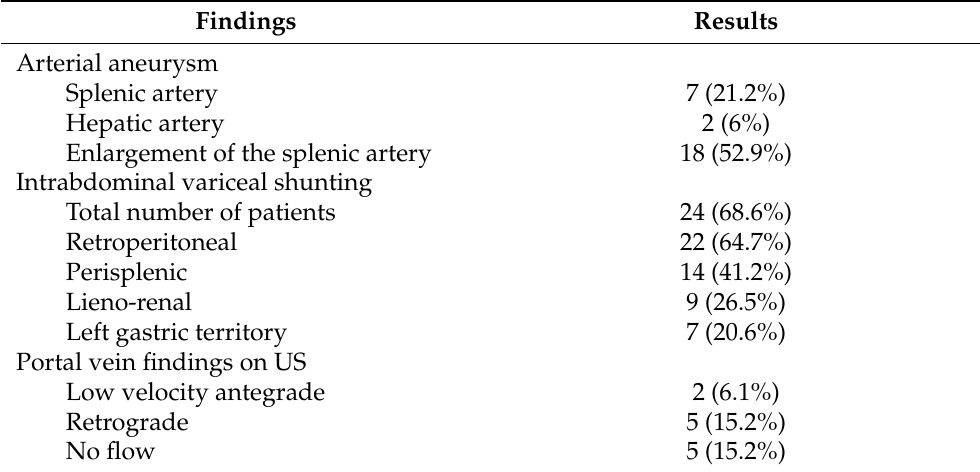
Figure 1. CT imaging pretransplant. ( A ) Central hypertrophy of the liver with atrophy of the left lateral segment and right lobe. ( B ) Calcified hepatic artery and splenic artery aneurysms. ( C ) Significant enlargement of the splenic artery and multiple aneurysms. Table 3. Findings on